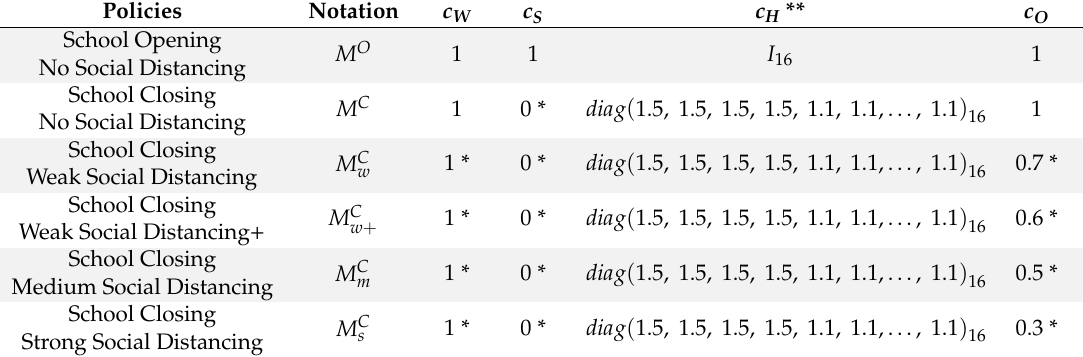
Figure 4. Schematic diagram for the mathematical model.